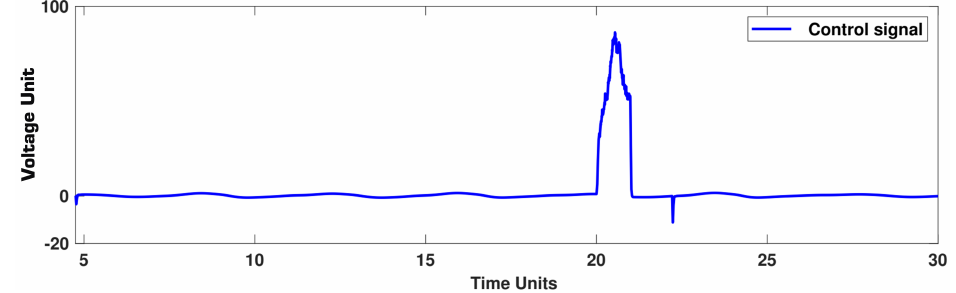
Figure 17. Example 4: Control signal.